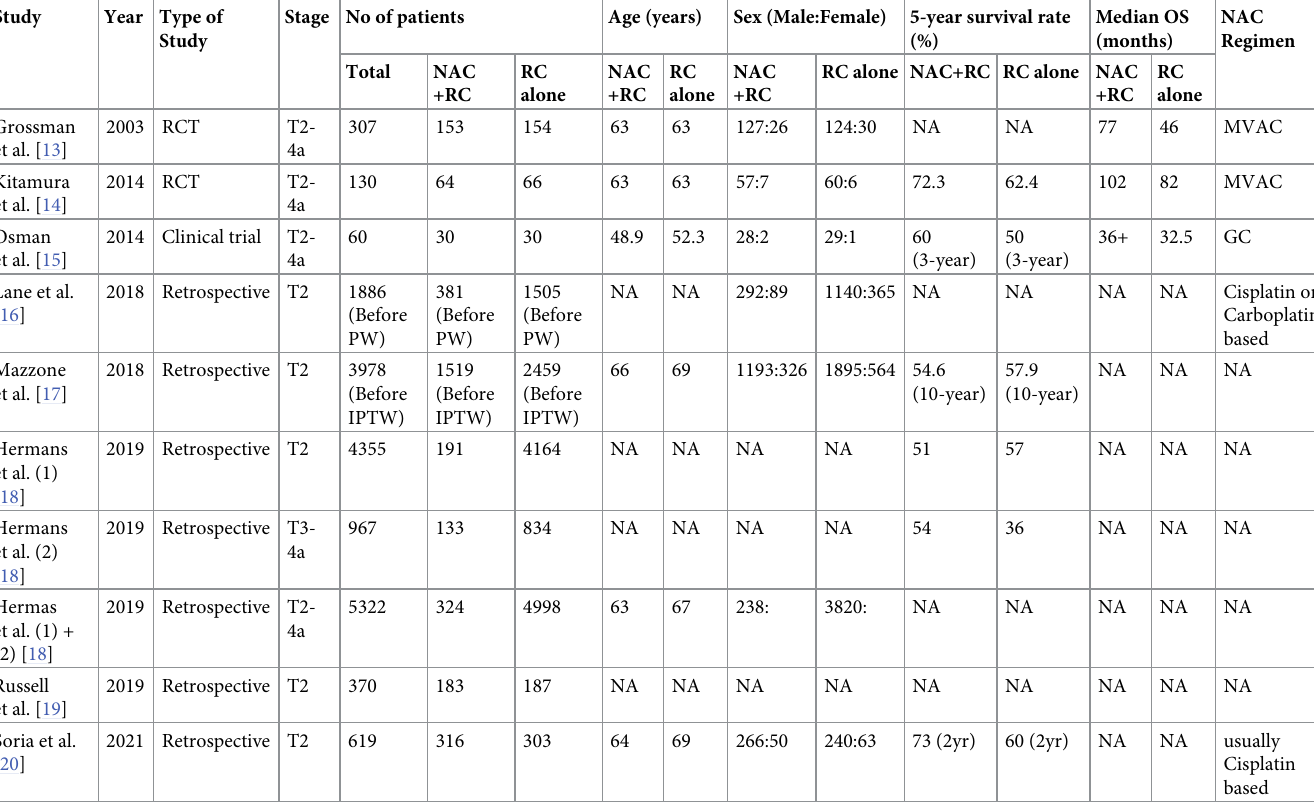
Table 1. Characteristics of included studies.